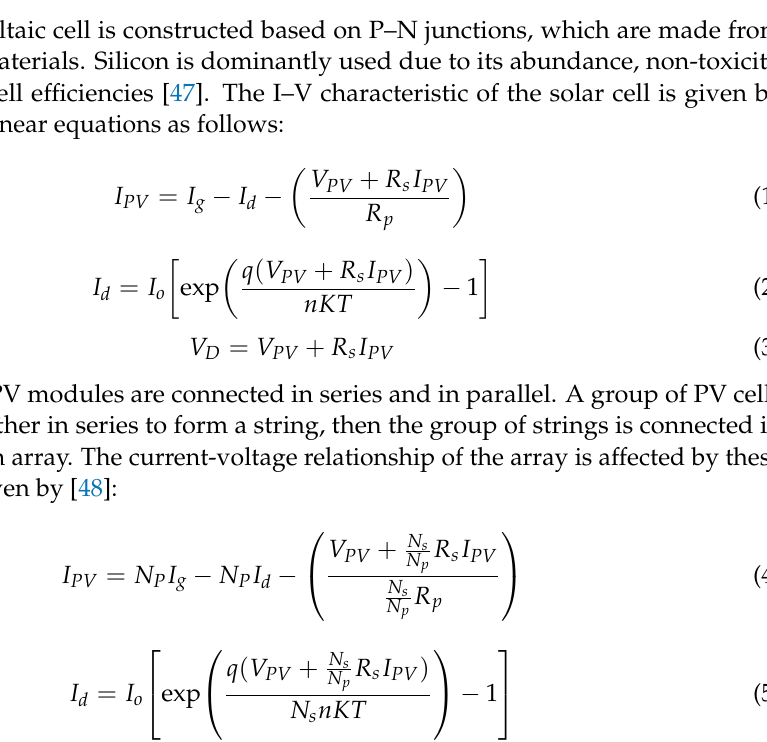
Figure 3. Equivalent circuit of PV array.